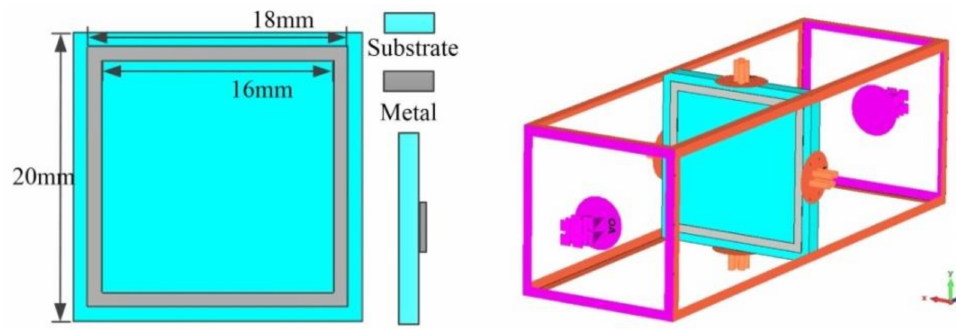
Figure 2. Structure and simulated model of the superstrate unit cell.